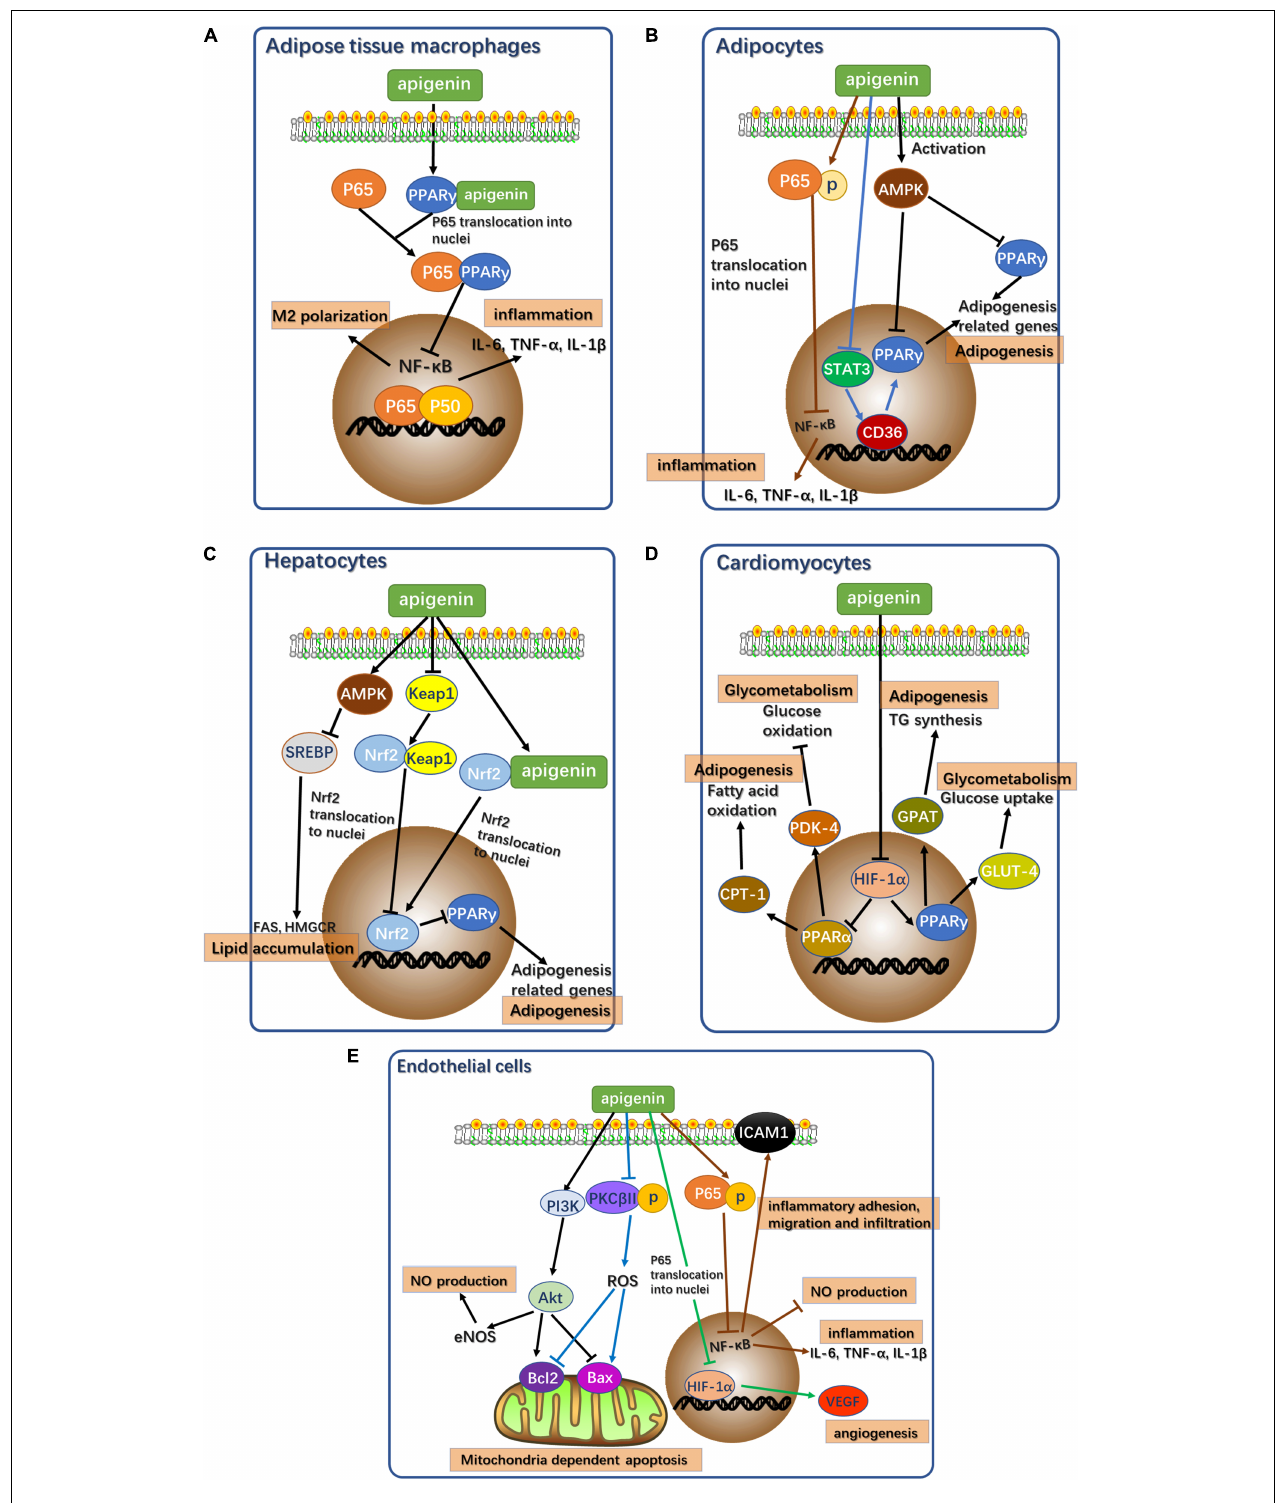
FIGURE 2 | Potential signaling pathways of apigenin affecting cardiometabolic diseases in different types of cells. (A) Potential signaling pathways of apigenin affecting cardiometabolic diseases in adipose tissue macrophages. p65: RelA, NF- κ B component. P50: p50 NF- κ B component. (B) Potential signaling pathways of apigenin affecting cardiometabolic diseases in adipocytes. AMPK, AMP-activated protein kinase. p65: RelA, NF- κ B component. STAT3, Signal transducer and activator of transcription 3. (C) Potential signaling pathways of apigenin affecting cardiometabolic diseases in hepatocytes. AMPK, AMP-activated protein